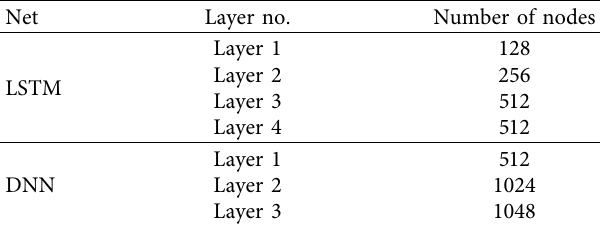
Table 4: Number of nodes for each layer of LSTM and DNN.